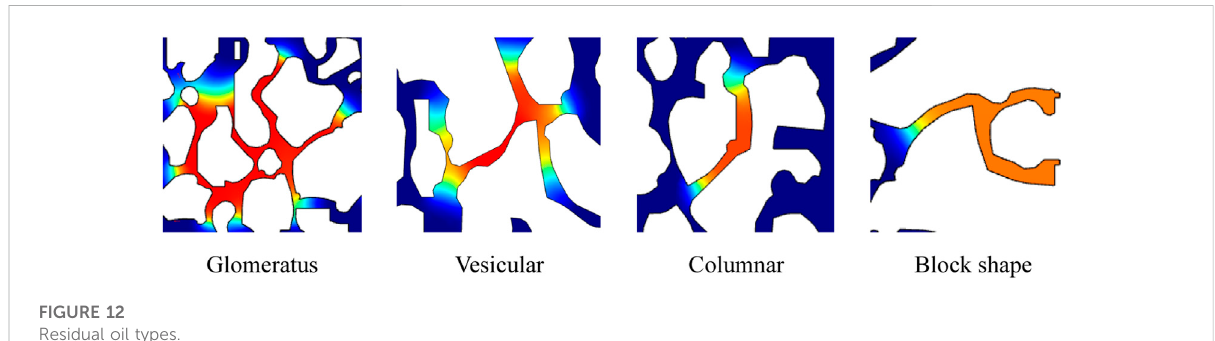
FIGURE 12 Residual oil types.